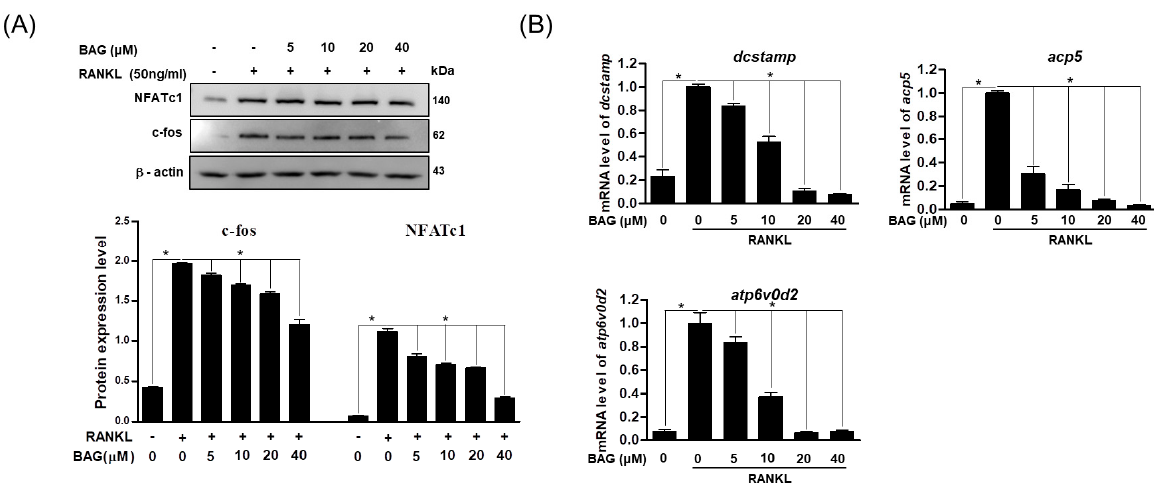
Figure 5. BAG downregulates RANKL-induced expression of osteoclast specific protein and gene. ( A ) For total proteins from RAW264.7 stimulated with RANKL without or with indicated concentration for 24 h, Western blot analyses were performed using specific antibodies against c-Fos and NFATc1. The protein expression of c-Fos and NFATc1 relative to b-actin were quantified by densitometry. ( B ) The mRNA level of osteoclast-specific genes was measured by real-time PCR. * p < 0.05 versus the RANKL-treated group.